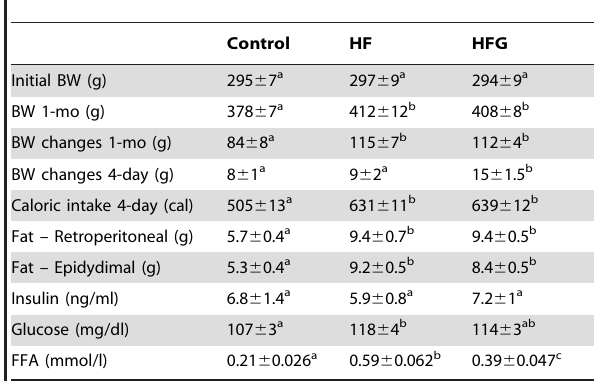
Table 1. Initial body weight (BW), body weight at the end of the one-month dietary treatment (before start of ghrelin or saline injection treatments), body weight changes before start of ghrelin or saline treatments, body weight changes during 4-day ghrelin or saline treatments, total 4-day caloric intake during 4- day ghrelin or saline treatment, retroperitoneal and epidydimal fat pad weights, plasma insulin, glucose and free fatty acids (FFA) concentrations in the three experimental groups.